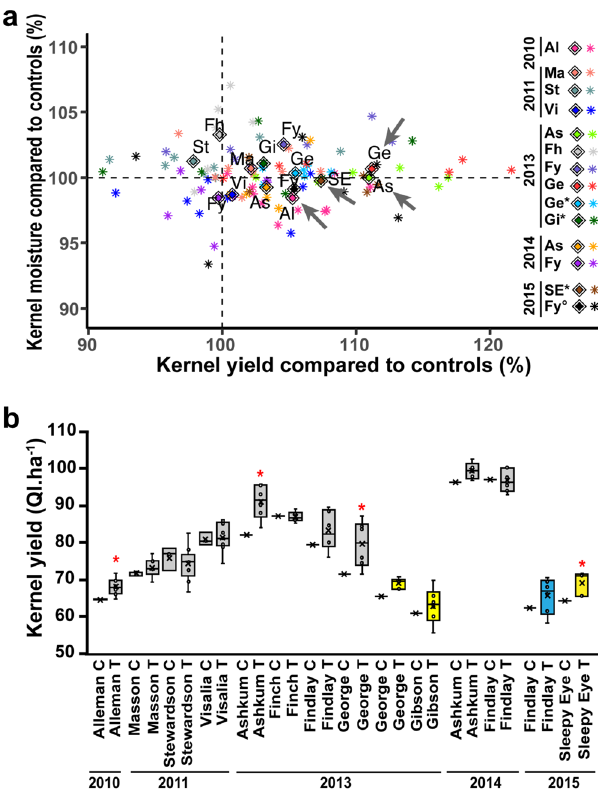
Fig. 3 Impact of Gln1-3 overexpression on kernel yield of maize hybrids grown in the fi eld over fi ve years in different locations. a Relationship between kernel yield (measured in Ql. ha − 1 ) and of kernel moisture (% compared to the control hybrids and null segregants) corresponding to the difference between the mean of all the different transgenic hybrids overexpressing Gln1-3 and the mean of the two types of control hybrids (colored diamonds). The colored asterisks represent the different transgenic events tested in the different locations over the fi ve years of experimentation: Alleman (Al) in 2010 (pink). Masson (Ma), (orange); Stewardson (St) (green) and Visalia (Vi) (dark blue) in 2011. Ashkum (As), (light green); Finch (Fh), (light gray); Findlay (Fy), (violet); George (Ge), (red); George (Ge*),(cyan) and Gibson (Gi*), (dark green) in 2013. Ashkum (As), (yellow − orange) and Findlay (Fy), (dark purple) in 2014. Sleepy Eyes (SE*), (brown − orange) and Findlay (Fy°) (black) in 2015. Presence of a moderate water de fi cit in George (Ge*) and Gibson (Gi*) in 2013, Sleepy Eyes (SE*) in 2015, and water-saturated soil conditions in Findlay (Fy°) in 2015. The data are from Supplemental Data 4 in which the number of transgenic events, the years of experimentation, the locations, the experimental design, and the statistical analyses are presented. The list of different transgenic events used in the fi eld experiments is summarized in Supplemental Data 1a. The signi fi cant increase in kernel yield in a location ( p < 0.05) is indicated by a gray arrow Alleman (Al) in 2010, Askhum (As) in 2013, George (Ge) in 2013, and Sleepy Eyes (SE) in 2015. b Box plots showing details of kernel yield obtained over the fi ve years of experimentation (2010, 2011, 2013, 2014, and 2015) in the different locations in the control hybrids (C) and in the transgenic hybrids (T). The yellow boxes indicate the presence of a moderate water de fi cit and the blue symbol water-saturated soil conditions. The black dots in the box represent the different transgenic events and the horizontal line in the box the average value for kernel yield. The Signi fi cant increase in kernel yield in a location ( p < 0.05) is indicated by a red